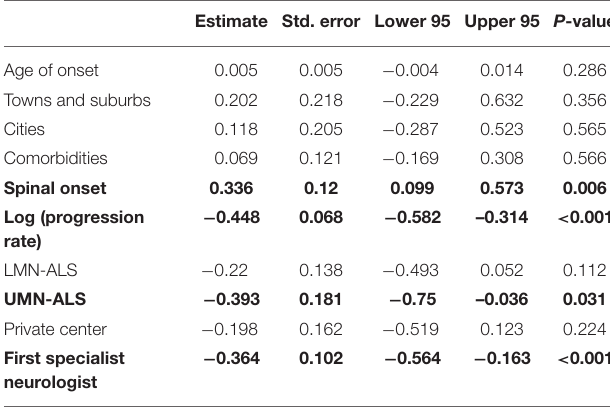
TABLE 2 | Multivariable model assessing the effect of several variables in the time symptoms-neurologist.